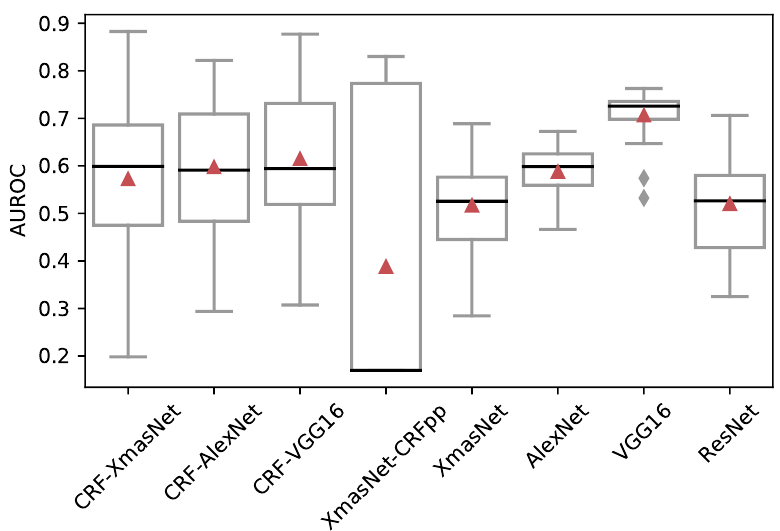
Figure 3. Boxplots of the AUROC obtained on the test set by the different architectures over 30 independent runs. Each boxplot shows a solid black line and a red triangle marker that denote the median and mean values,